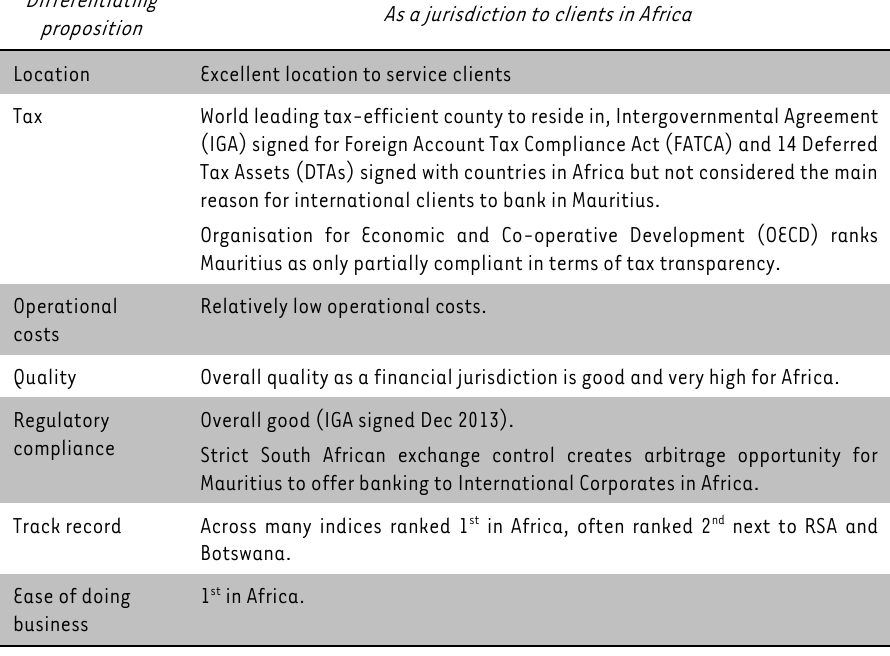
TABLE 6: Data depicted in template ‘where’ Differentiating